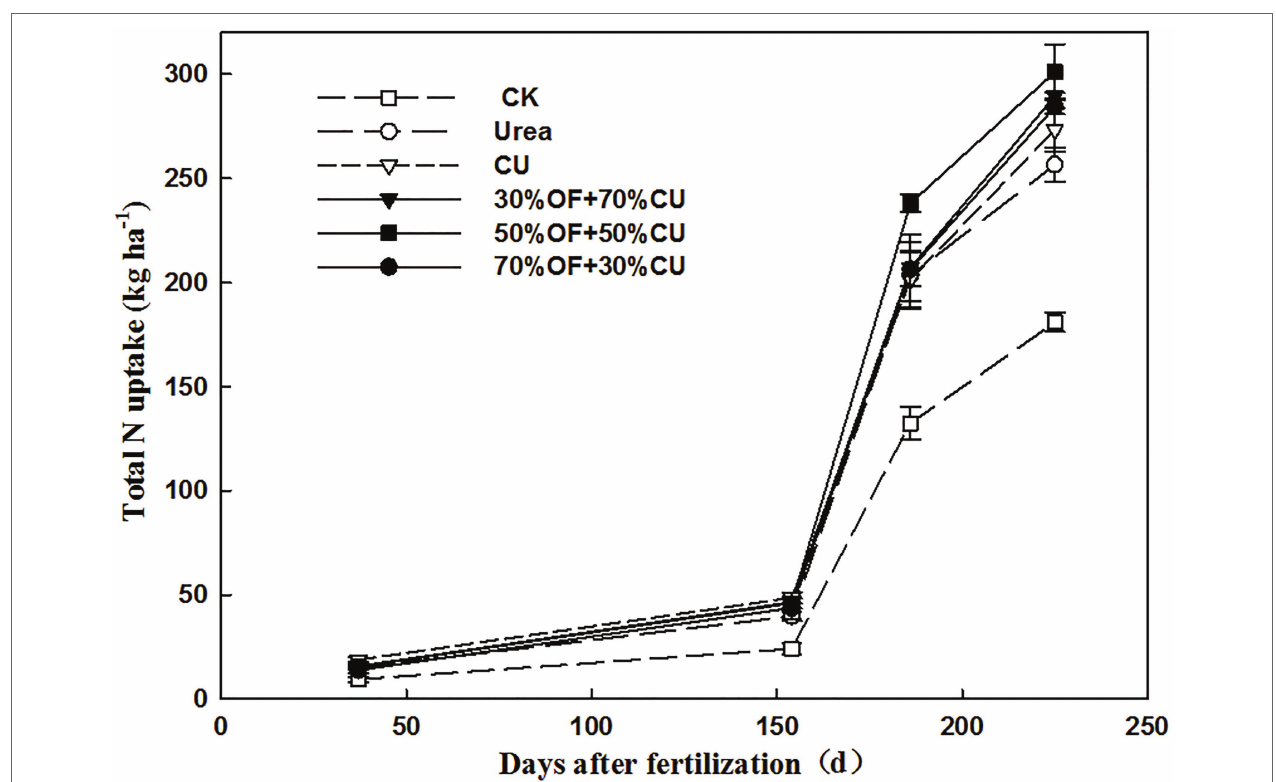
FIGURE 4 | Total N uptake of wheat plants during the growing